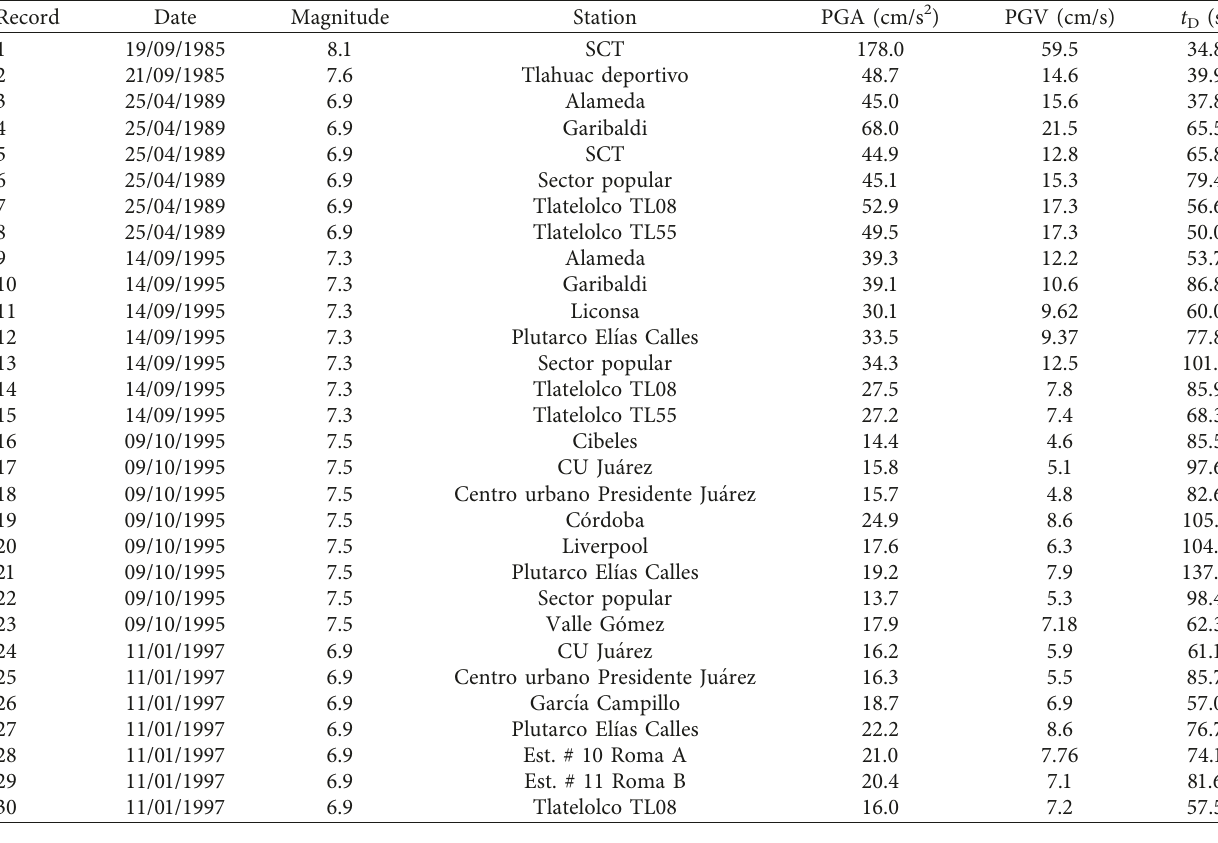
Table 2: Narrow-band motions used for the present study.